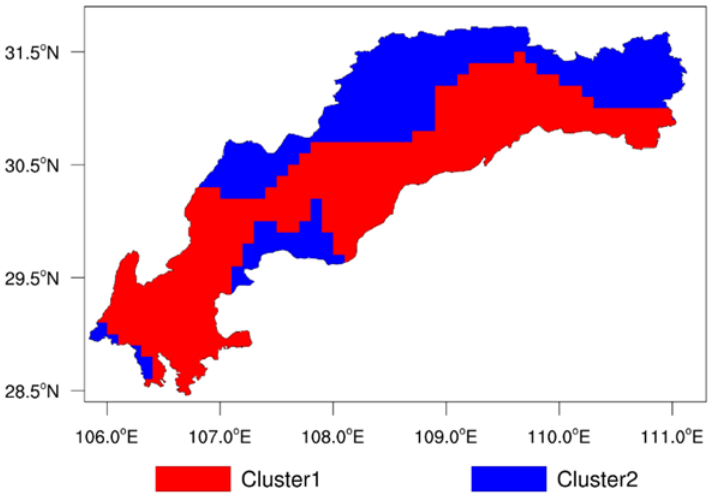
Figure 5. Cluster analysis results of meteorological factors.